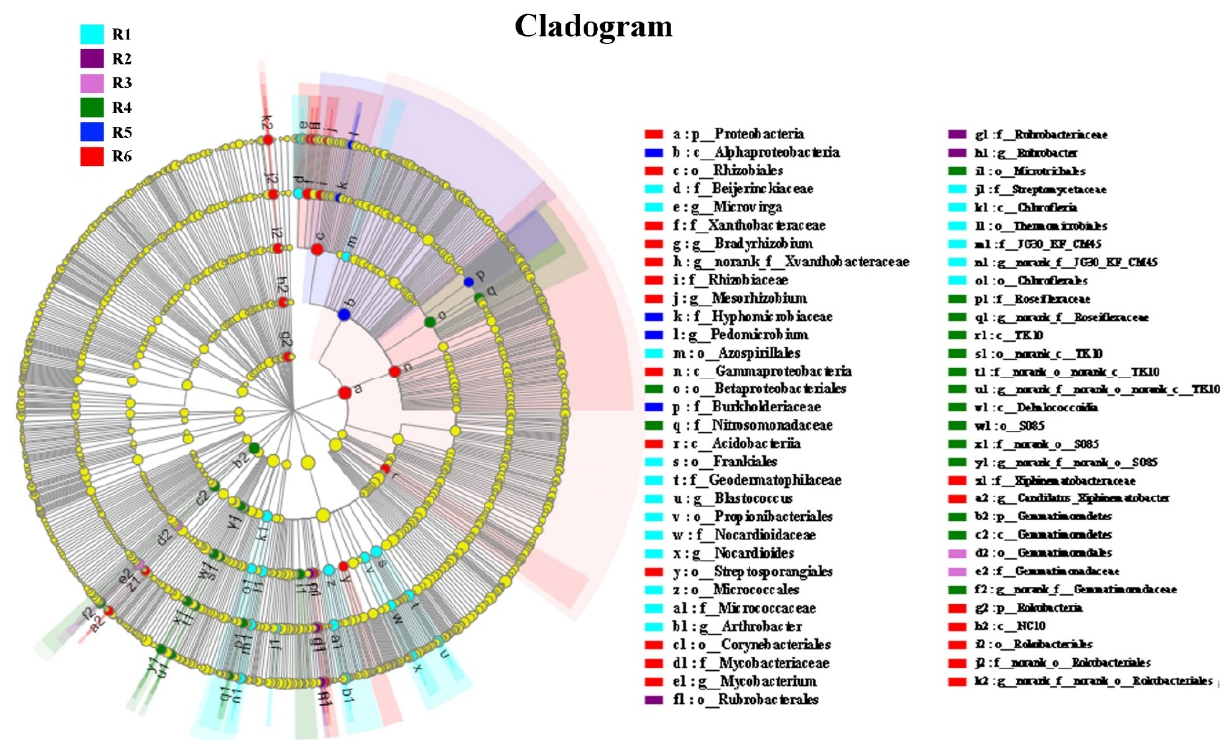
Figure 4. Cladogram indicating the phylogenetic distribution of microbial lineages associated with six different successional stages on the Loess Plateau of China; lineages with LDA values of 3.5 or higher determined by LEfSe are displayed. Differences are represented by the color of the most abundant microbial groups (In Figure 4, sky blue indicates farmland (R1), dark purple indicates pioneer weeds (R2), light purple indicates herbage (R3), green indicates shrub (R4), dark blue indicates early forest (R5), red indicates climax forest (R6), and yellow indicates non-significant). Each circle’s diameter is proportional to the abundance of the taxon. Circles represent phylogenetic levels from phylum to genus, from the inside out.